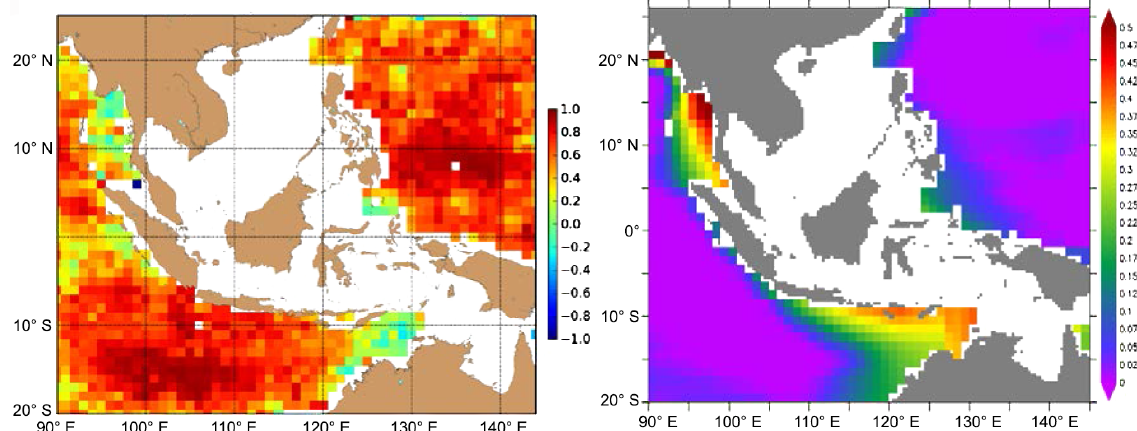
Figure 9. Mean temporal correlation between the (INDO12-Aquarius) SSS bias and the (INDO12-JAMSTEC) SSS bias and salinity inter- polation error of JAMSTEC (ARGO + TRITON + CTD) calculated from August 2011 to December